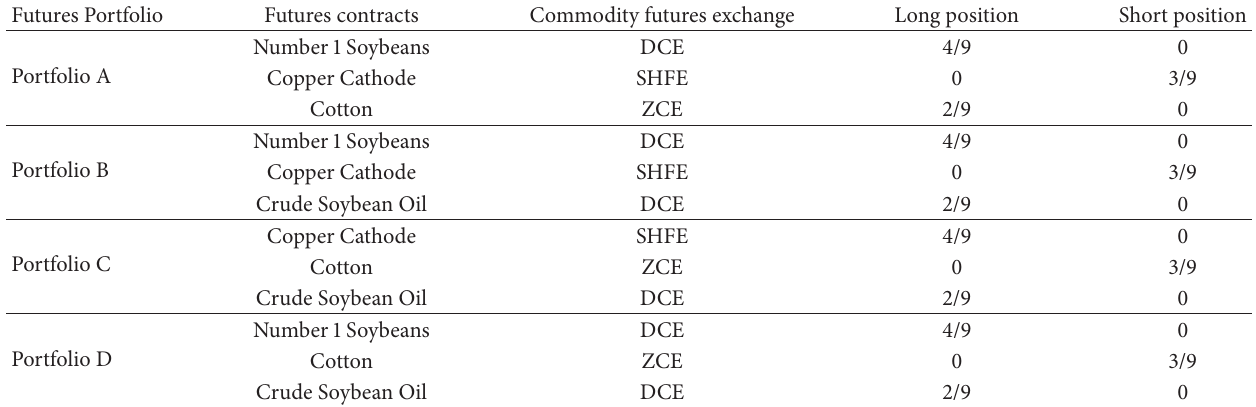
Table 1: Allocation of the gross position for four kinds of Futures Portfolios.